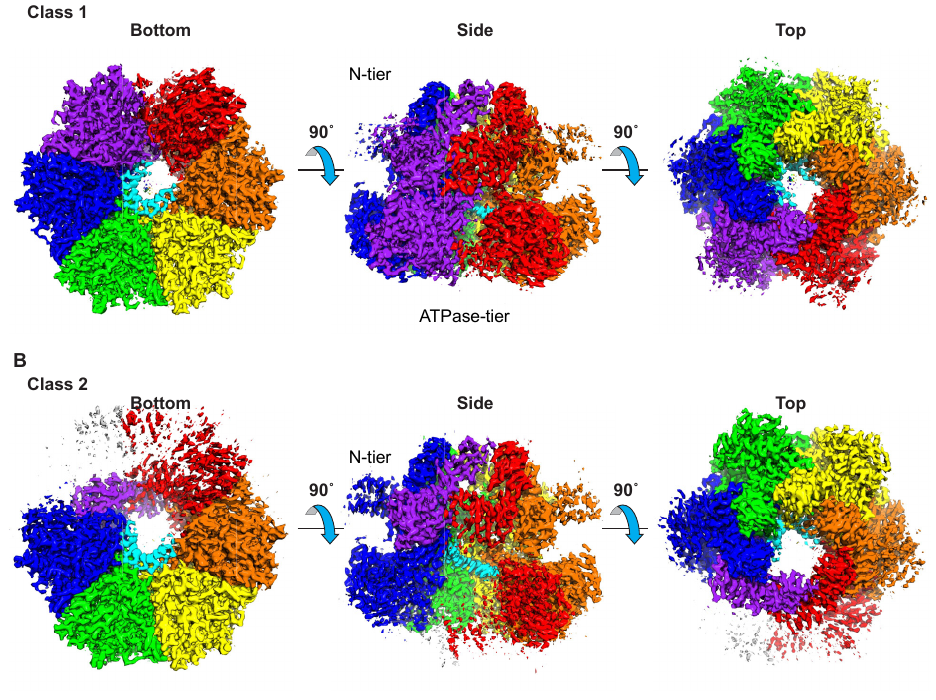
Figure 1. Overall architectures of the two structural classes of MCM–ssDNA–MgADP-BeF 3 . Three orthogonal, consistent views are illustrated for the two classes. The “side” view is perpendicular to the central channel with the N-terminal tier on top and the ATPase tier on the bottom. The “bottom” view is parallel to the central channel from the ATPase tier side. The “top” view is parallel to the central channel from the N-terminal tier side. The illustrated maps were obtained by refinement of the merged particles of the respective classes obtained for three different oligonucleotides (see Fig- ures S2–S4). Both classes consist of a two-tiered hexameric ring that binds single-stranded DNA at the larger ATPase tier. The defined views place the N-terminal tier at the top of the complex and the ATPase tier at the bottom. Each figure panel was prepared with Chimera [47]. ( A ) The final sharp- ened map following homogeneous refinement of class 1 is colored by subunit proximity to the atomic model coordinate file. Class 1 has 6 well-defined domains at both tiers. The peripheral helical bundle subdomains of the N-terminal tier appear less ordered than the other subdomains. ( B ) The final sharpened map following homogeneous refinement of class 2 is colored by subunit proximity